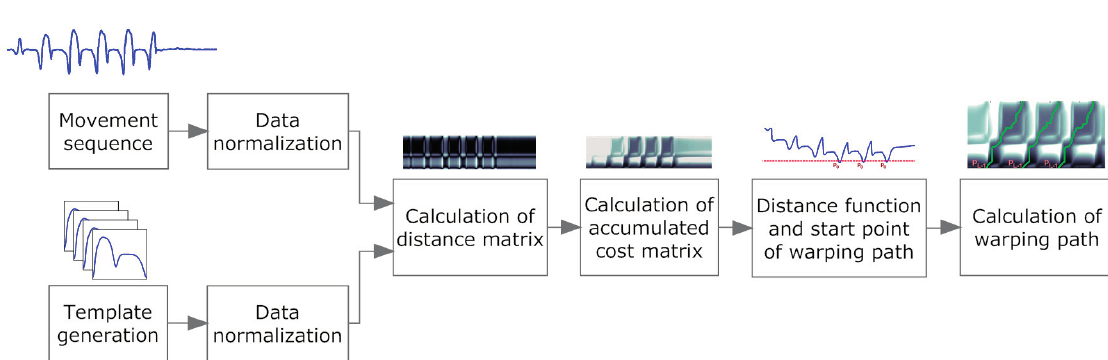
Figure 3. Illustration of the signal processing workflow for the msDTW algorithm, related